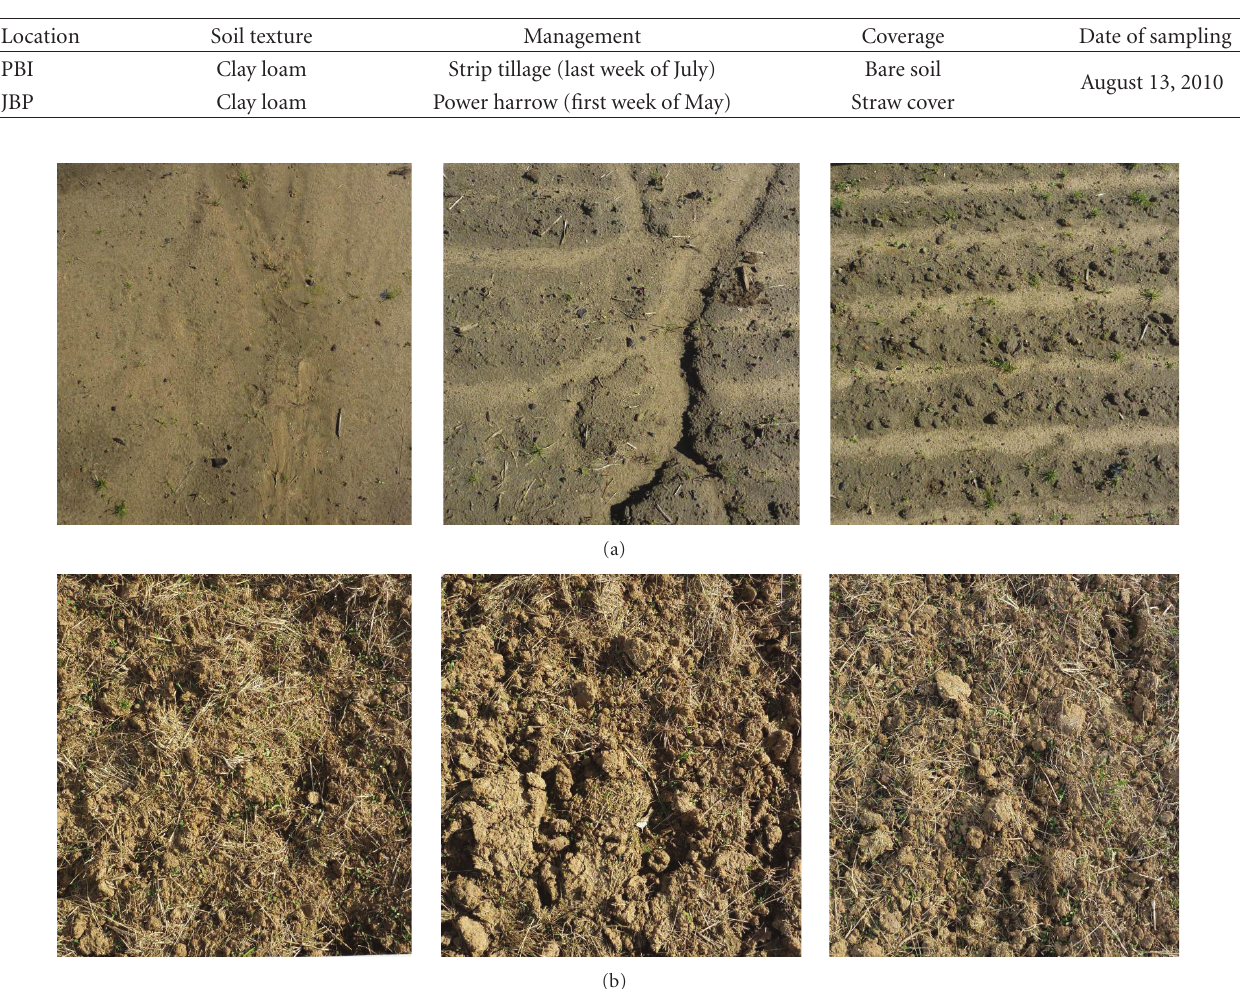
Figure 3: Soil surface roughness (SSR) images of PBI plots (1 cob, 2 cob, and 3 cob on (a) L-R) and JBP plots (1 jbp, 2 jbp, and 3 jbp on (b) L-R). Each measurement was taken three